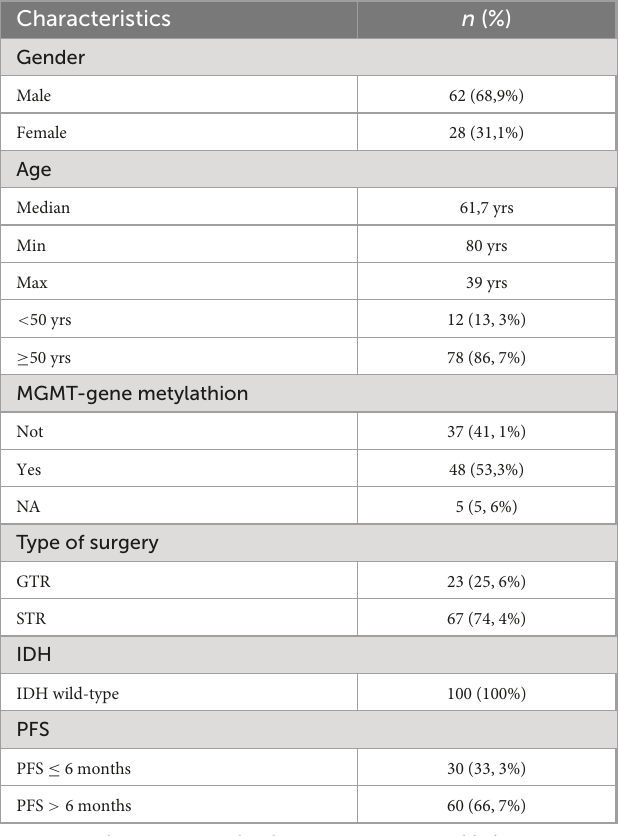
TABLE 2 Clinical data characteristics of patients with glioblastoma (GB) ( n = 90).